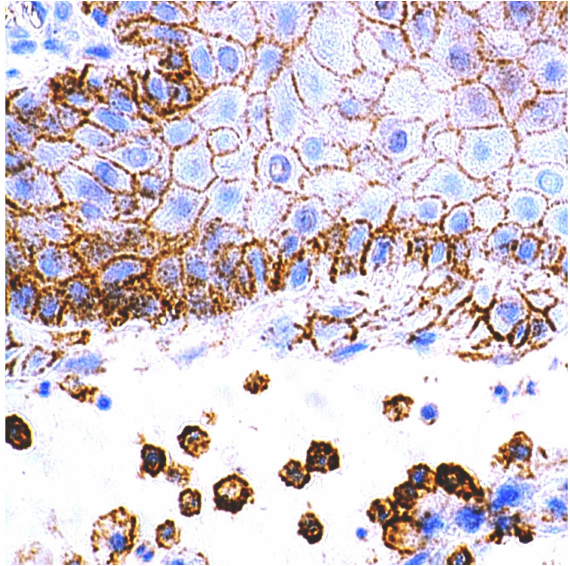
Figure 6. Immunohistochemical visualization of the CD44 marker in epithelium and mononu- clear cells of lamina propria of healthy oral mucosa. Immunoperoxidase, anti-CD44, original magnification 400 × .